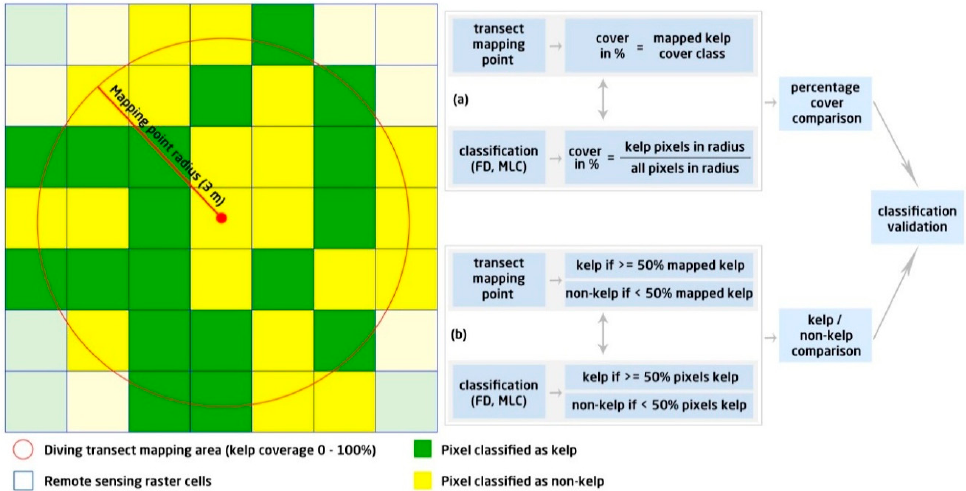
Figure 3. Validation of the Feature Detection (FD) and Maximum Likelihood Classification (MLC) results using a single diving transect mapping point: ( a ) percentage coverage comparison and ( b ) kelp/non-kelp detection.